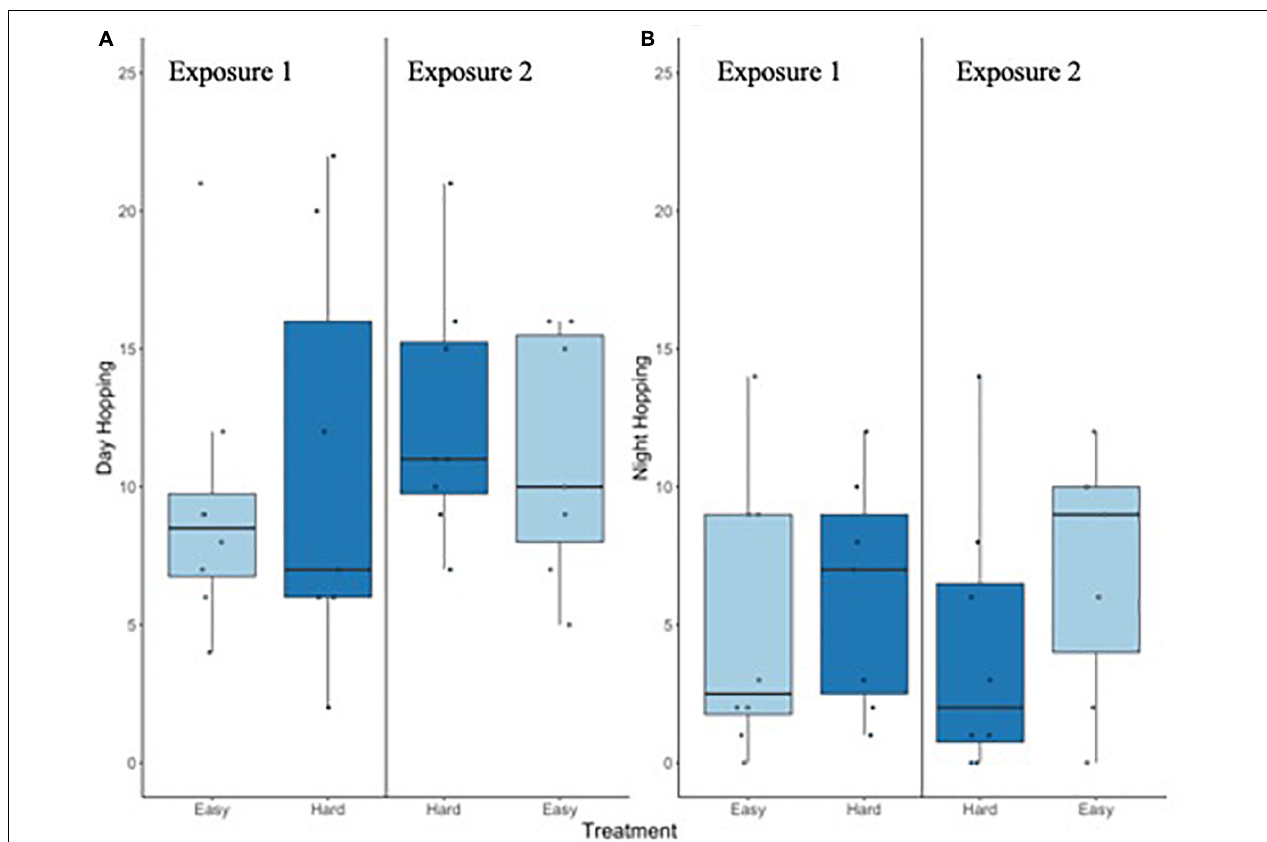
FIGURE 8 | Number of 15-min intervals in which escape-type hopping was observed during daylight hours ( A ; all intervals scored) and at night ( B ; sampled hourly) on the day prior to blood sampling. This type of activity was not significantly affected by workload regime or